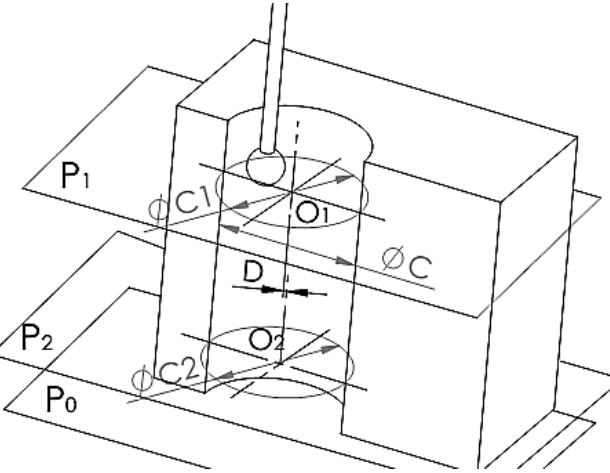
Figure 4. Measured elements.